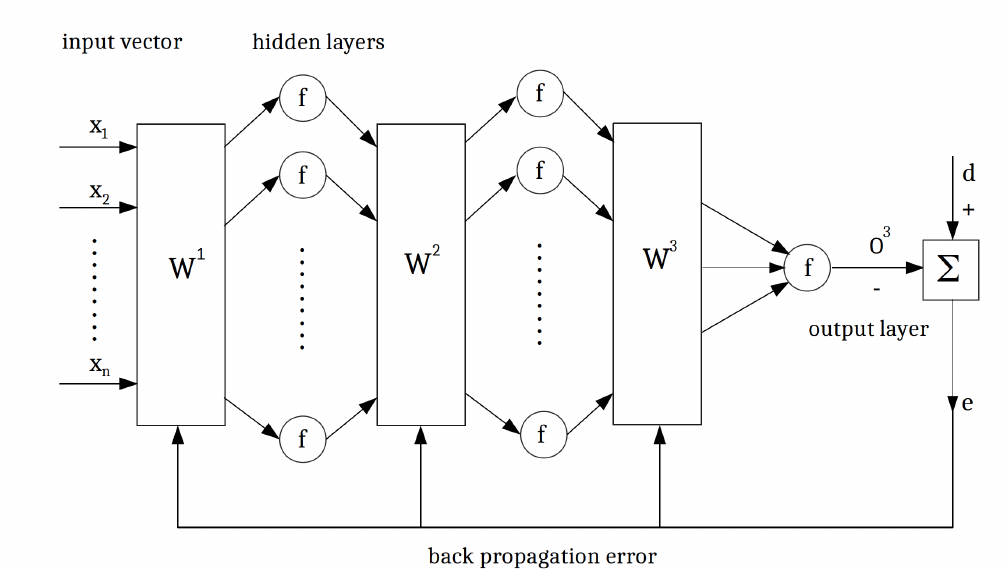
Figure 8. The structure of the MFNNs